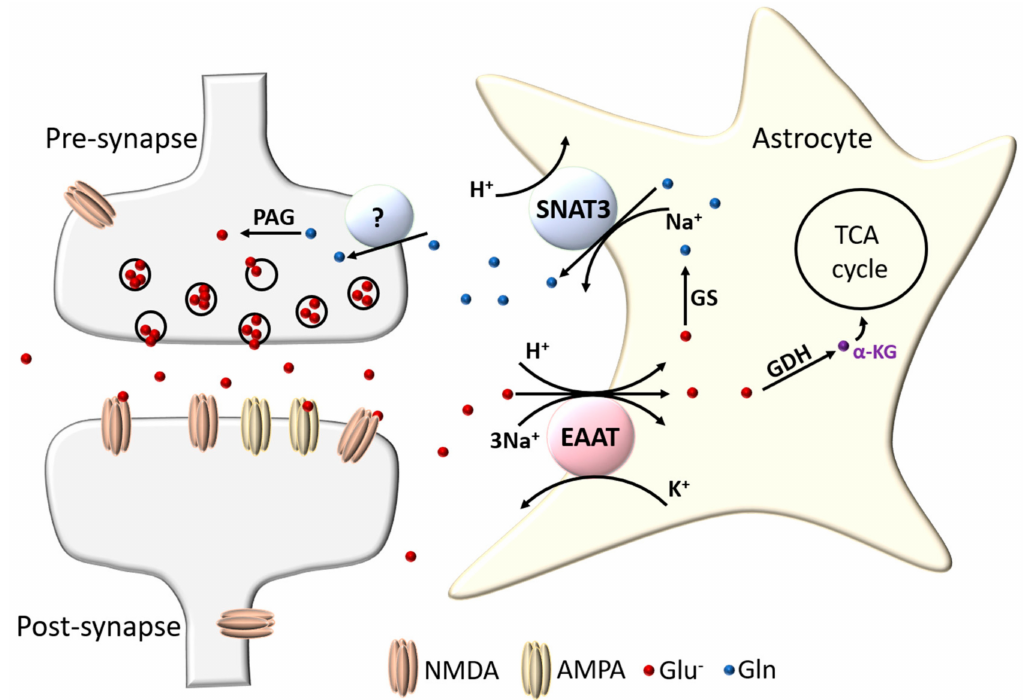
Figure 1. Glutamate-glutamine cycle. Glutamate (Glu − ) released after excitatory transmission is collected by astrocytic EAAT transporters 1 and 2. The glutamate is then either converted into α -ketoglutarate ( α -KG) via glutamate dehydrogenase (GDH) or transaminase reaction and enters the TCA cycle, or else is converted into glutamine (Gln) by glutamine synthetase (GS). Astrocytes excrete Gln back into the extracellular environment via the Na + driven SNAT3 transporter, which is then taken up by an as yet unconfirmed neuronal Gln transporter. Neurons then convert Gln back to Glu − via a phosphate-activated glutaminase (PAG) reaction to replenish their vesicular Glu −